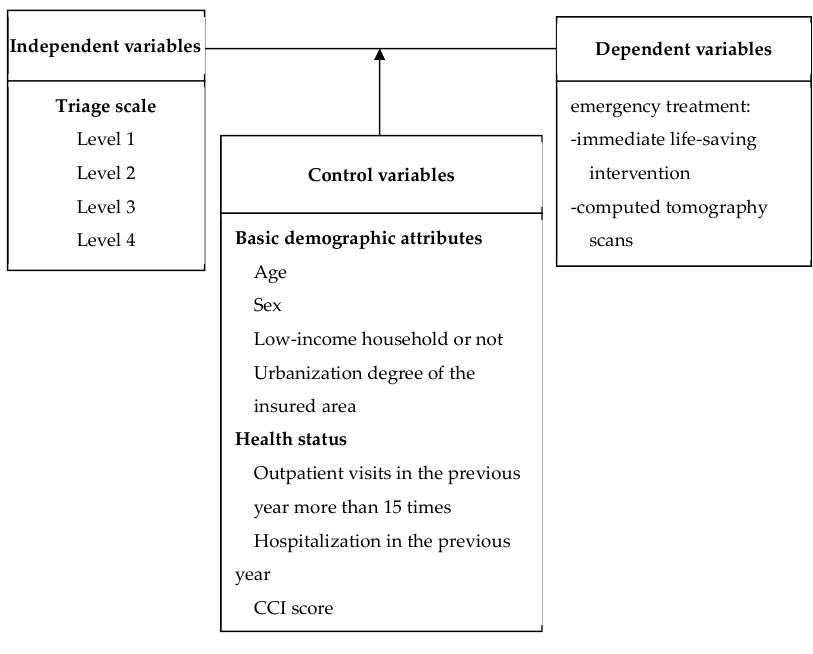
Figure 1. Research structure.